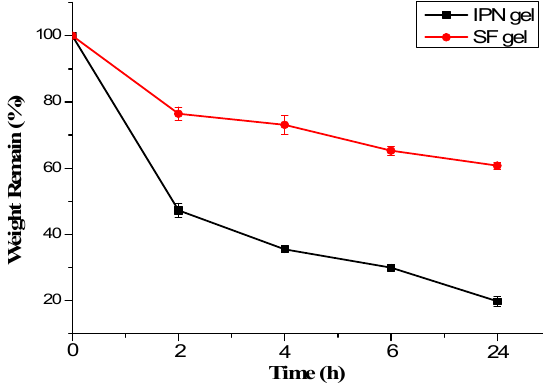
Figure 5. Degradation of silk fibroin hydrogels. In 2 U/mL protease XIV PBS solution (37 °C, pH: 7.4). The solid content of SF hydrogel was 10 g/L, SF:NVP was 8:2 and the thickness of material was 4.4 mm.